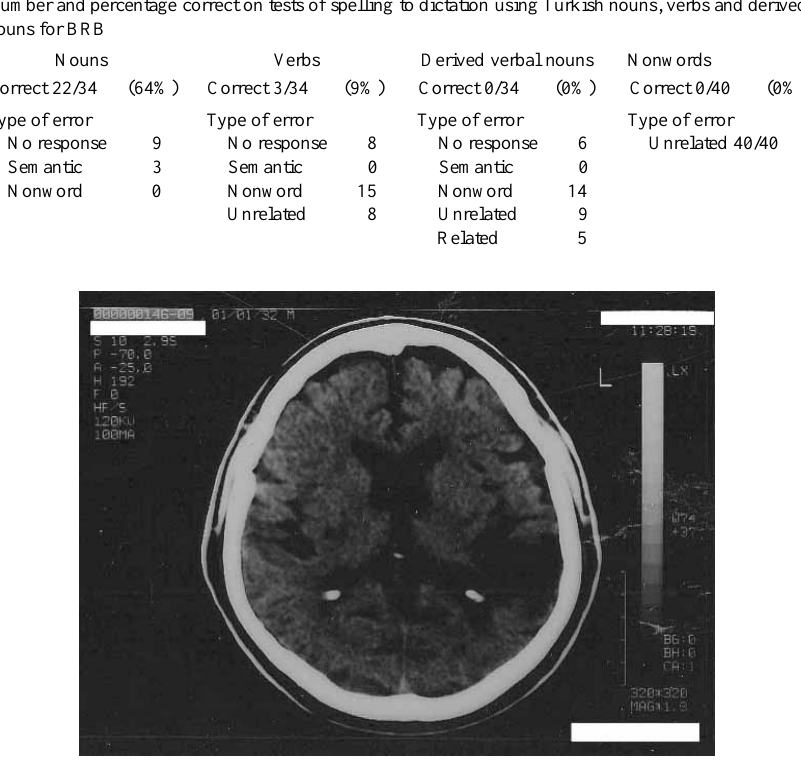
Table 1 Number and percentage correct on tests of spelling to dictation using Turkish nouns, verbs and derived